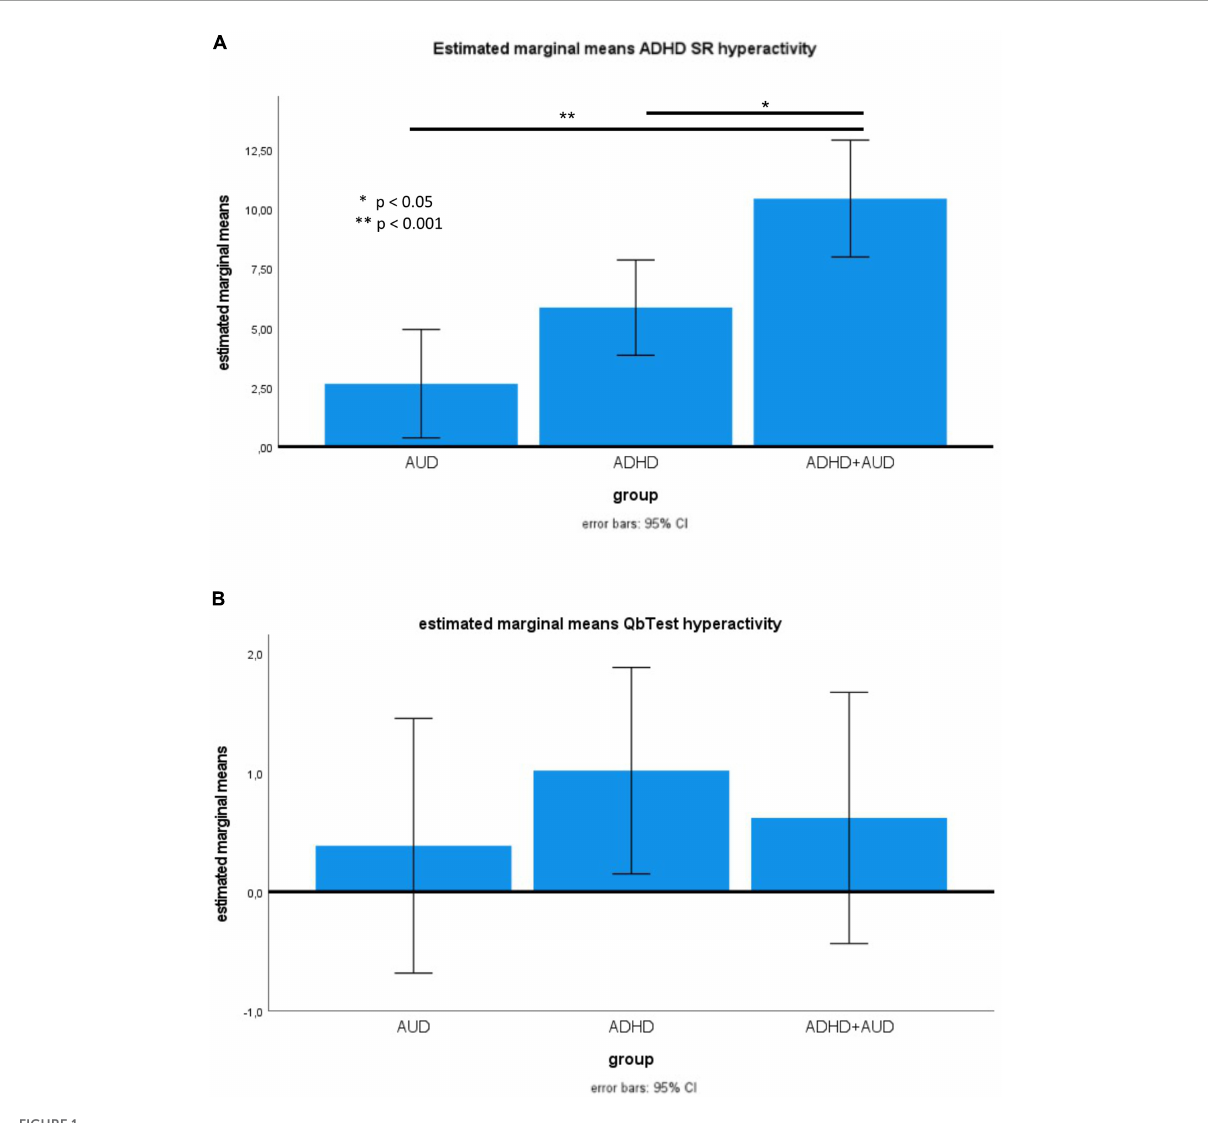
FIGURE1 (A) Estimated marginal means of ADHD-SR hyperactivity. (B) Means of Qb